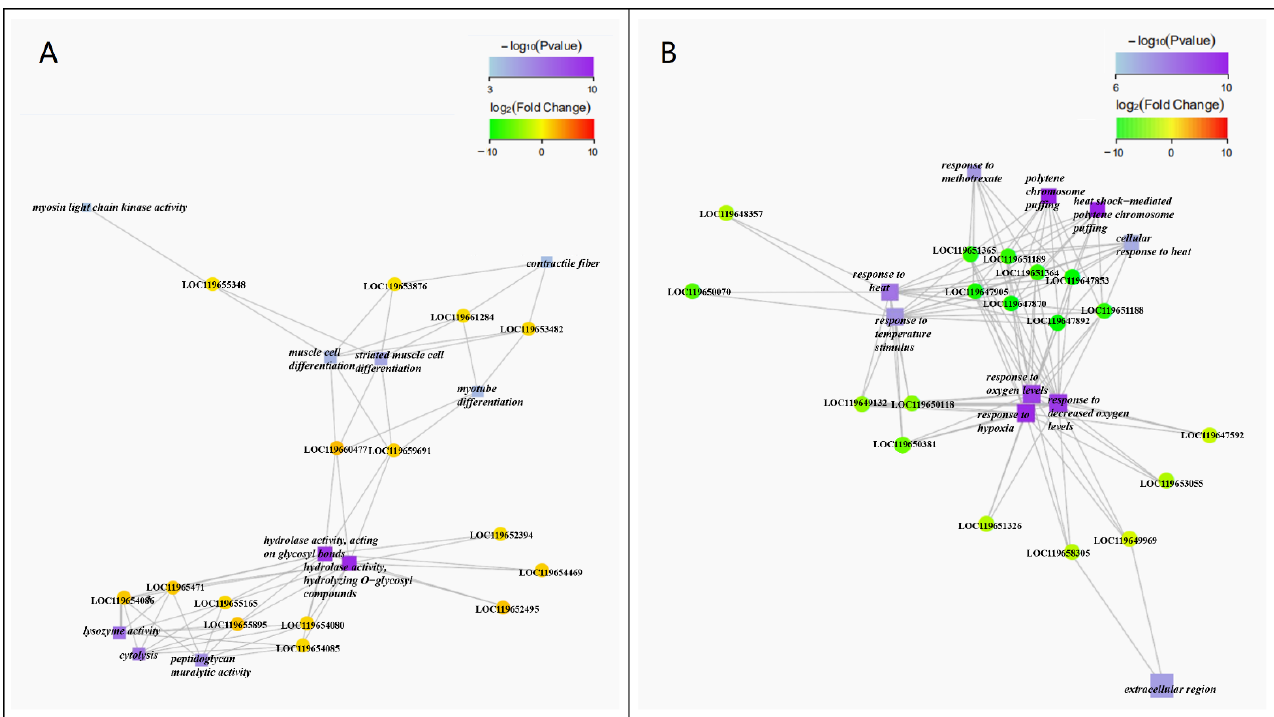
Figure 7. The GO enrichment network of significantly up-regulated ( A ) and down-regulated ( B ) gene functions and genes in the transcriptome comparison of C/N 18:1 vs. C/N 21:1. The blue-purple squares represent significantly regulated gene functions with the color correlated with the p value, and the green-yellow-red circles represent significantly regulated gene ID numbers with the color correlated with the fold changes.